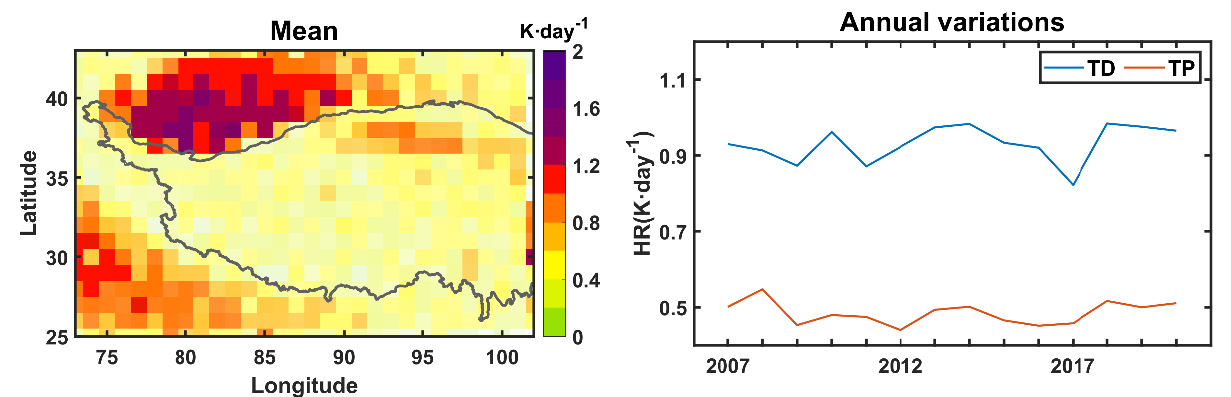
Figure 14. Seasonal distributions of mean SW DHRs in four altitude layers during 2007–2020. The four layers are 0–2, 2–4, 4–6, and 6–8 km, respectively. The empty spaces indicate the missing data.